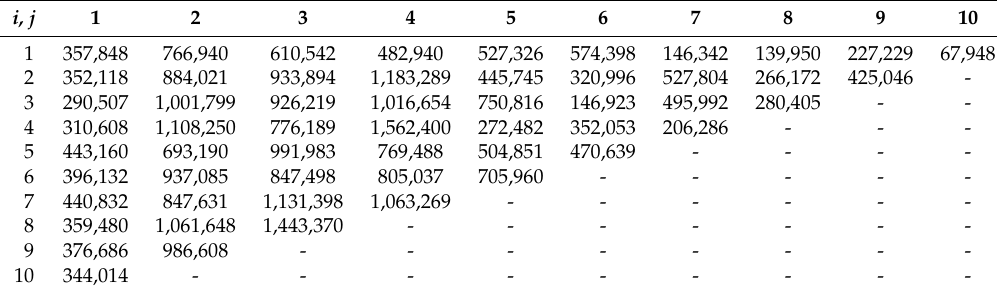
Table 1. Insurance run-off triangle taken from Taylor and Ashe (1983) as an example for a generalized trapezoid. Entries are aggregate incremental paid amounts for claims of accident year i and